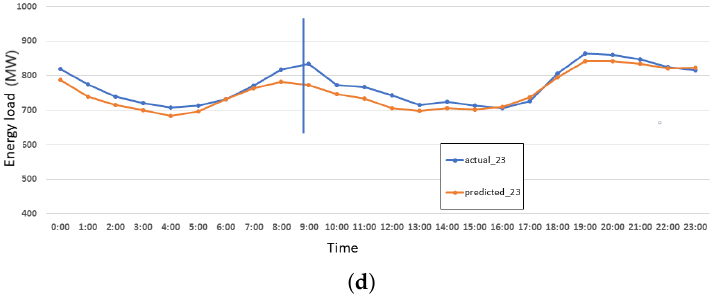
Figure 13. Highest errors recorded on Wednesdays in the month of January. ( a ) Wednesday, 2 January 2019; ( b ) Wednesday, 9 January 2019; ( c ) Wednesday, 16 January 2019; ( d ) Wednesday, 24 January 2019.